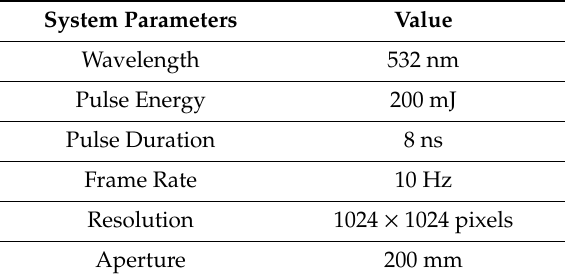
Figure 3. Experimental setup of super-resolution 3D imaging. Table 1. Parameters for 3D Imaging System.